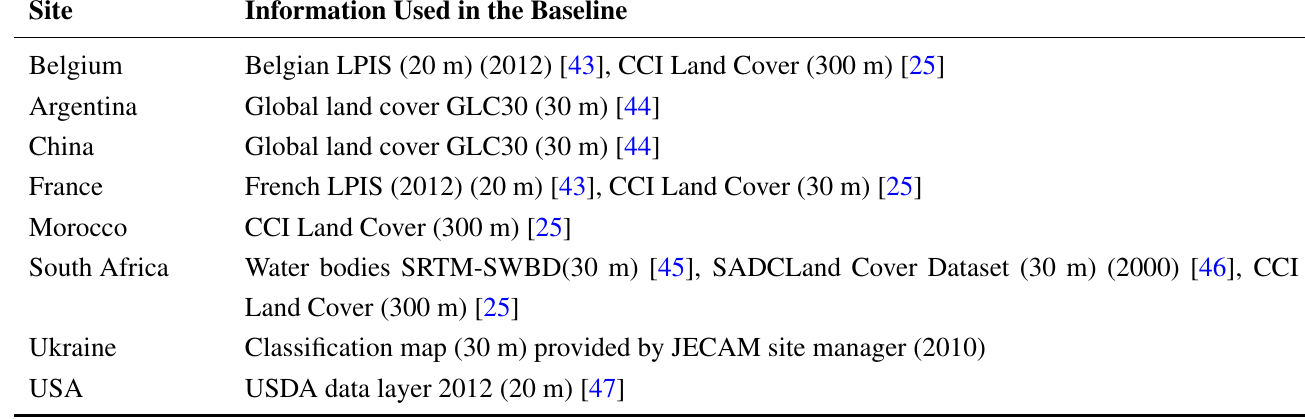
Table 4. Respective mapping source to build the baseline land cover information. This baseline serves as input for the classification. LPIS, Land Parcel Identification System; CCI, Climate Change